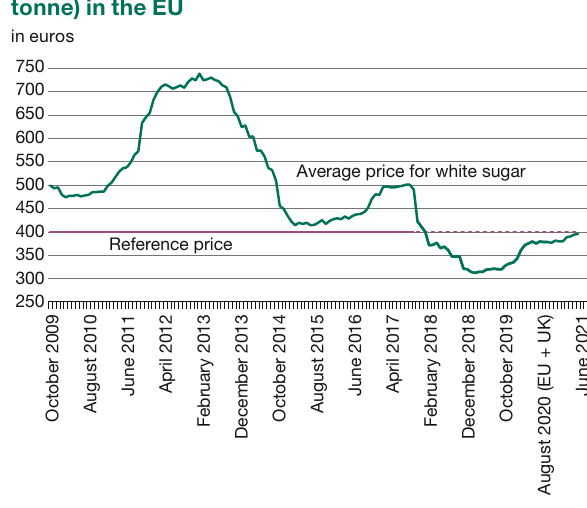
Figure 1 Average and reference price for white sugar (per tonne) in the EU